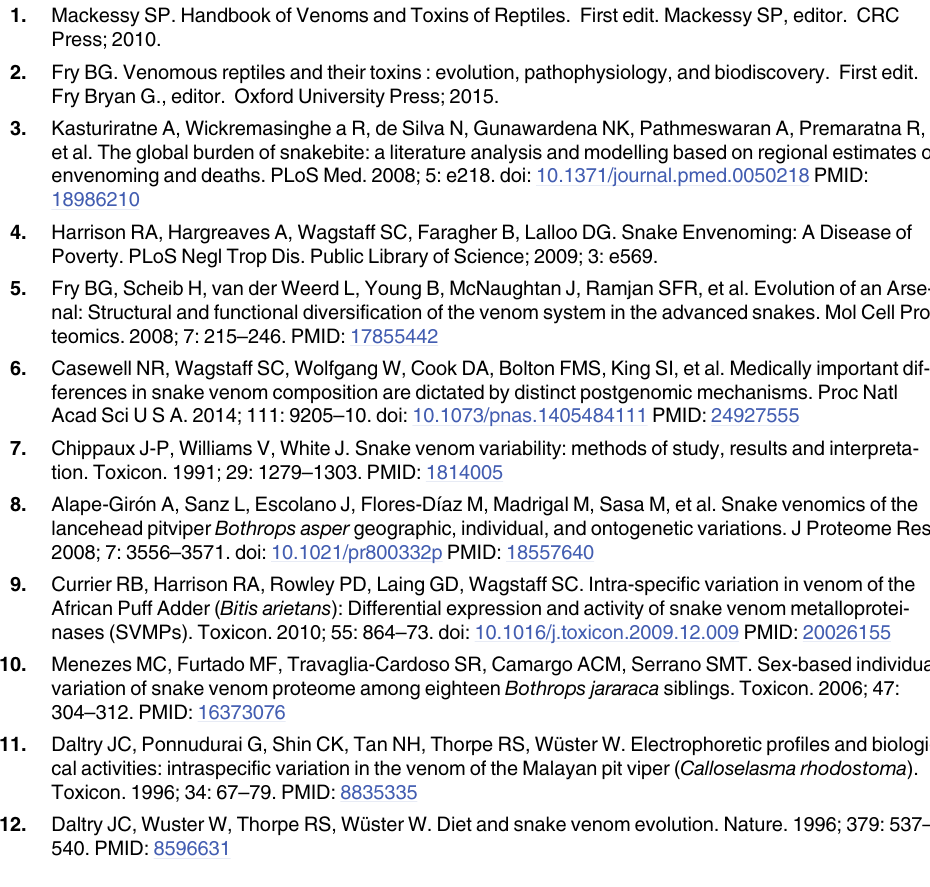
S1 Table. Primers for elapid PLA (A), KSPI (B), CTL (C) and SVMP (D). 2 (PDF) S1 Fig. Multiple sequence alignments for PLA2 (A), KSPI (B), CTL (C) and SVMP (D) amino acid sequences translated from transcripts isolated from the V TRZ of several